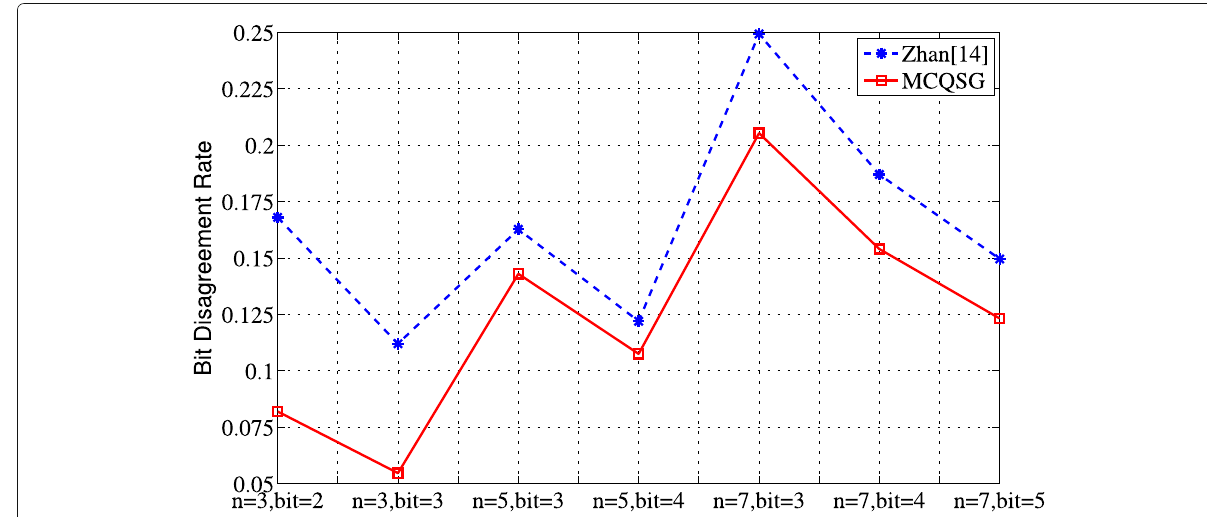
Fig. 14 Comparison of BDR of our and Zhan’s scheme